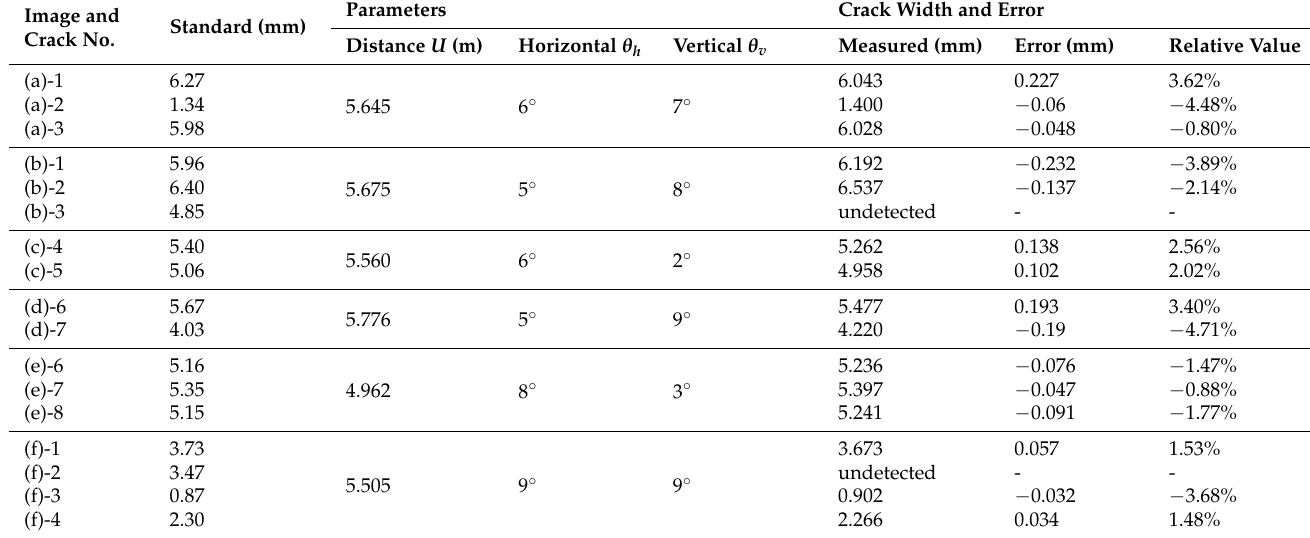
Table 8. Measurement results of cracks on the dam pier in Figure